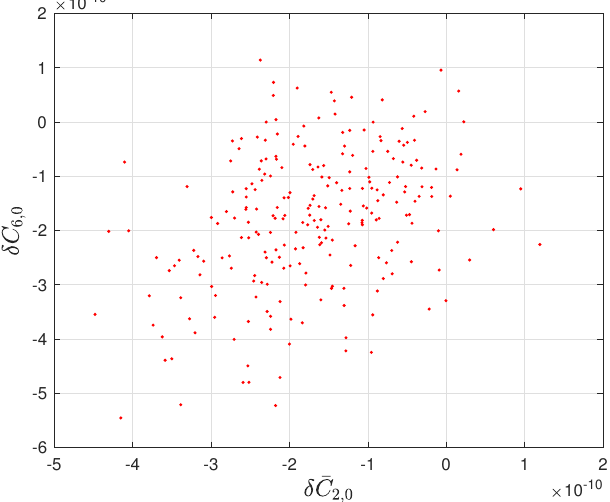
Figure 17. Correlation plot between the corrections to the quadrupole coefficient ¯ C 20 and to the hexadecapole coefficient ¯ C 60